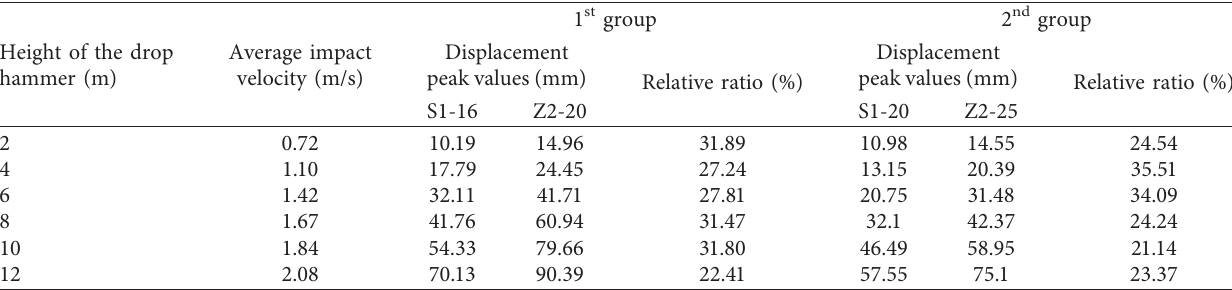
Table 8: Top displacement test results and